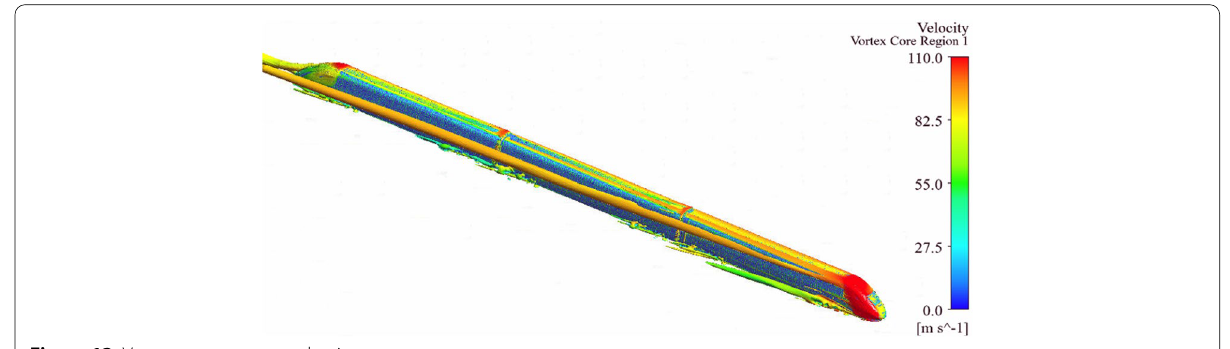
Figure 13 Vortex structure around train